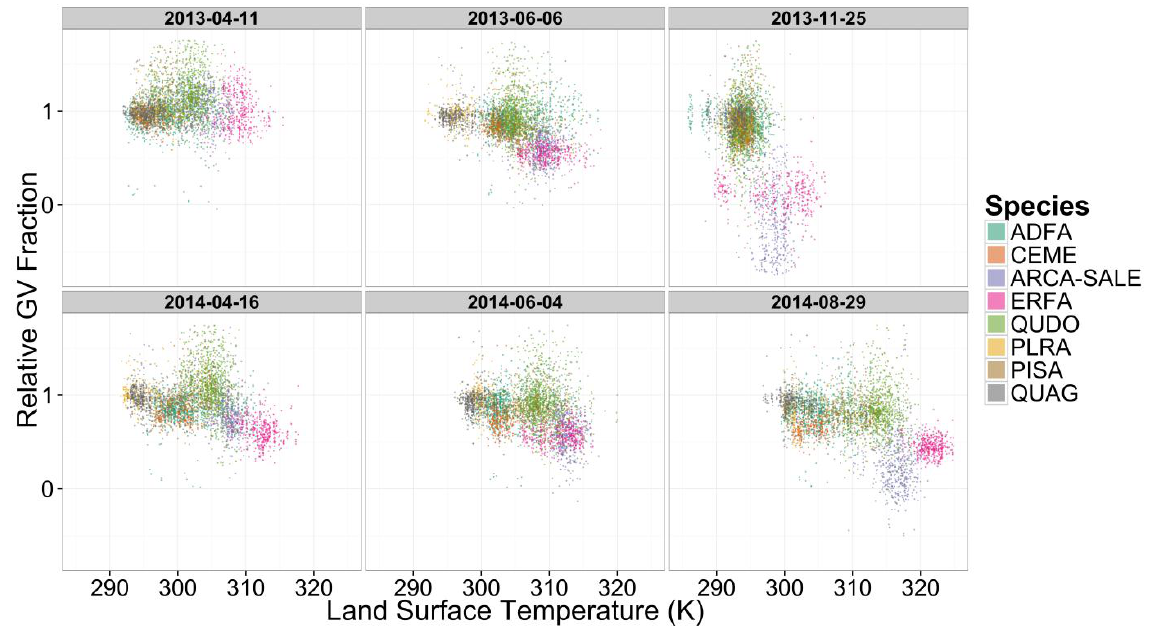
Figure 7. Land surface temperature versus relative GV fraction for pixels in species polygons. Species codes are listed in Table